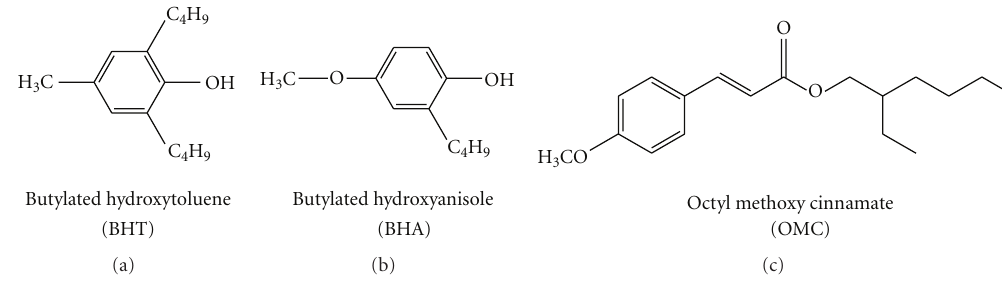
Figure 1: Structures of common phenolic compounds in personal care products.